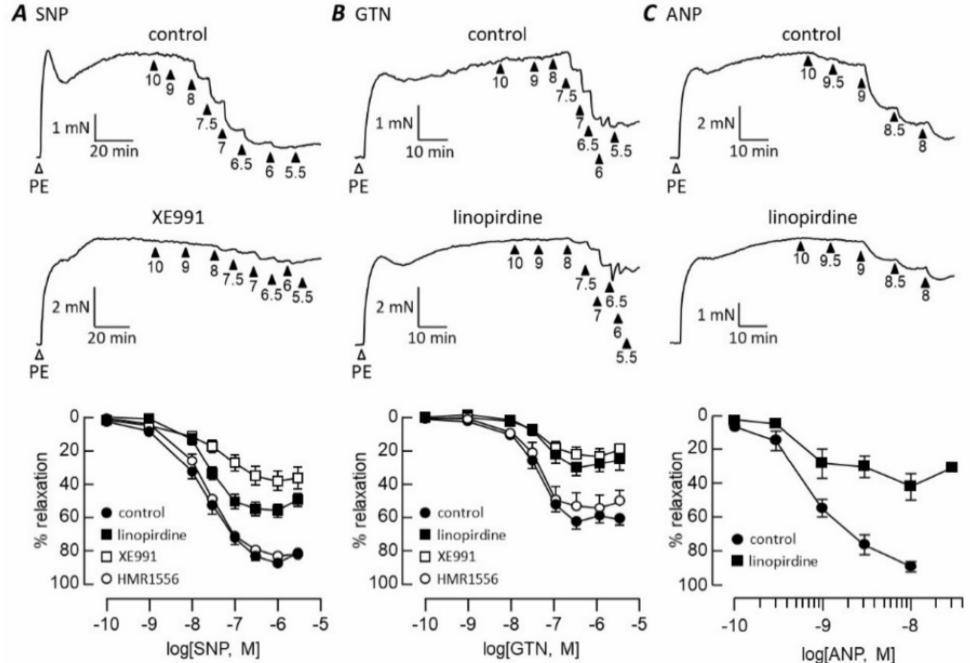
Figure 1. Kv7 channel blockers inhibit NO- and ANP-evoked relaxation. Traces illustrate pulmonary artery contraction to 1 µ M phenylephrine (PE), followed by relaxation responses to increasing concentrations of SNP ( A ), GTN ( B ) or ANP ( C ) applied cumulatively in control conditions (upper traces) and after incubation with 1 µ M XE991 or linopirdine (lower traces). Arrowheads indicate -log[dilator]. Concentration–response curves (bottom panel) are plotted in control conditions and after incubation with 1 µ M Kv7 blocker as indicated. SNP n = 5 (XE991), 9 (control) or 7; GTN n = 6; ANP n =